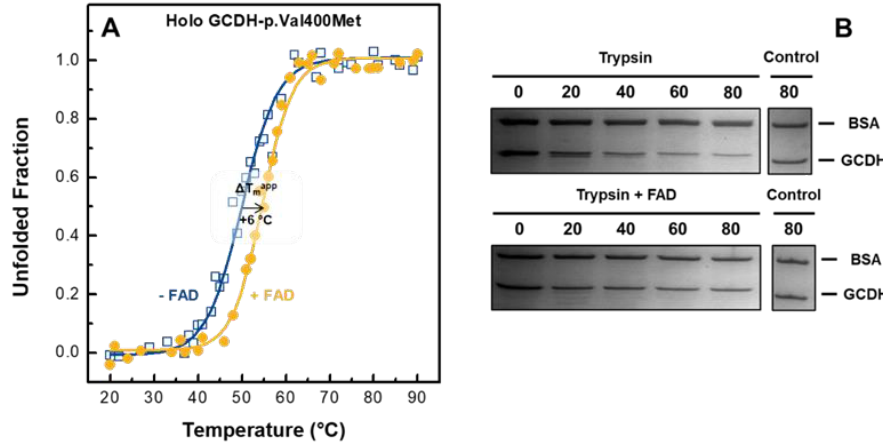
Figure 5. Effect of FAD on the conformational stability of holoprotein GCDH-p.Val400Met. ( A ) Representative thermal stability profiles obtained following ellipticity variation at 222 nm for the holoprotein in the absence (blue open squares) or presence (yellow closed circles) of flavin. The solid curves represent the best fits to a two-state model sigmoid from which the apparent melting temperatures were determined ( n = 3, see Material and Methods). ( B ) Effect of FAD on the susceptibility of GCDH-p.Val400Met to proteolysis. Proteolytic digestion at 37 °C for 80 min with trypsin in 0.1 M Tris/HCl pH 8.5 in the absence and presence of 2.5-fold excess of FAD as analyzed by SDS-PAGE. Control samples were incubated under identical conditions in the absence of trypsin. Bovine serum albumin was added to the loading buffer as an internal standard and to correct for variations in the amount of loaded